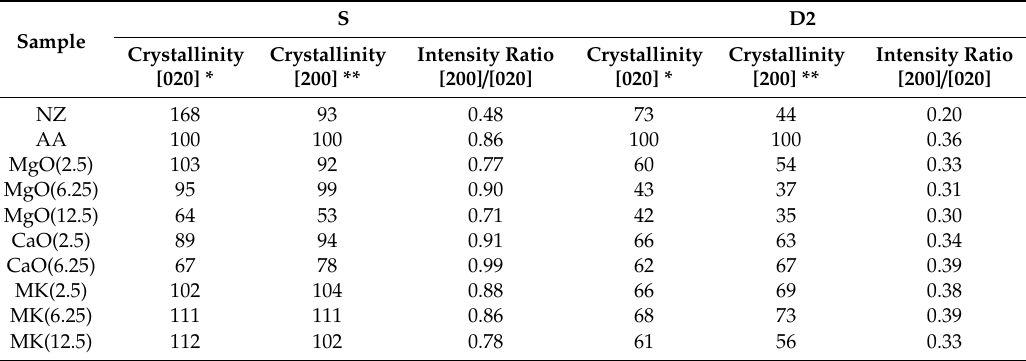
Figure 3. Di ff ractograms of “S” ( a ) and “D2” ( b ) samples series. Figure 3. Diffractograms of “S” ( a ) and “D2” ( b ) samples series. Table 2. Crystallinity and the intensity ratio of samples series “S” and